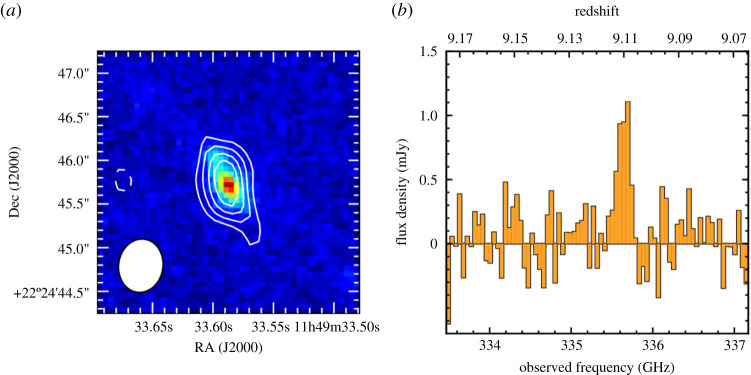
Current redshift record-holder with ALMA: [OIII] line detection at z = 9.1096. (a) HST image (F160W) with ALMA [OIII] contours. (b) ALMA spectrum, showing the 7-σ [OIII] 88 μm line detection in Band 7. Figure reproduced from Hashimoto et al. [582].